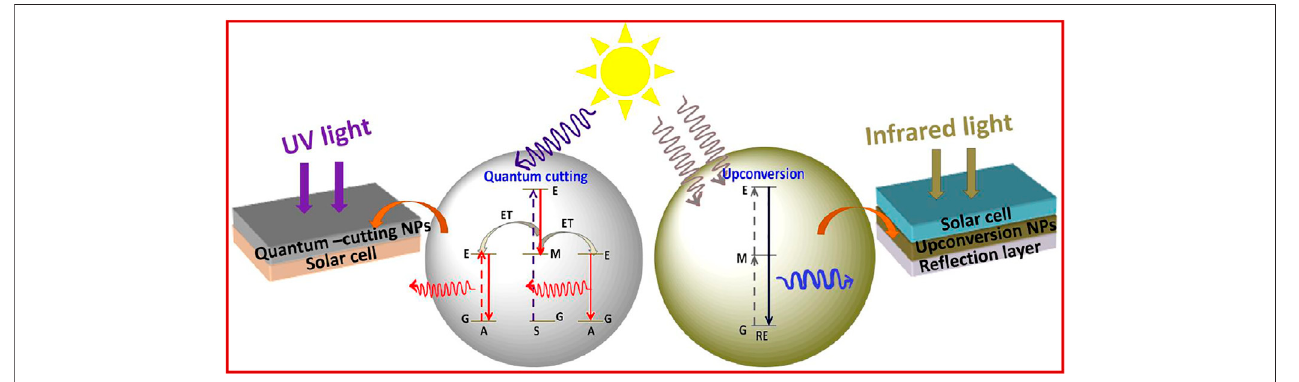
FIGURE 8 | Schematic representation of quantum cutting and upconversion nanoparticles in a solar cell.